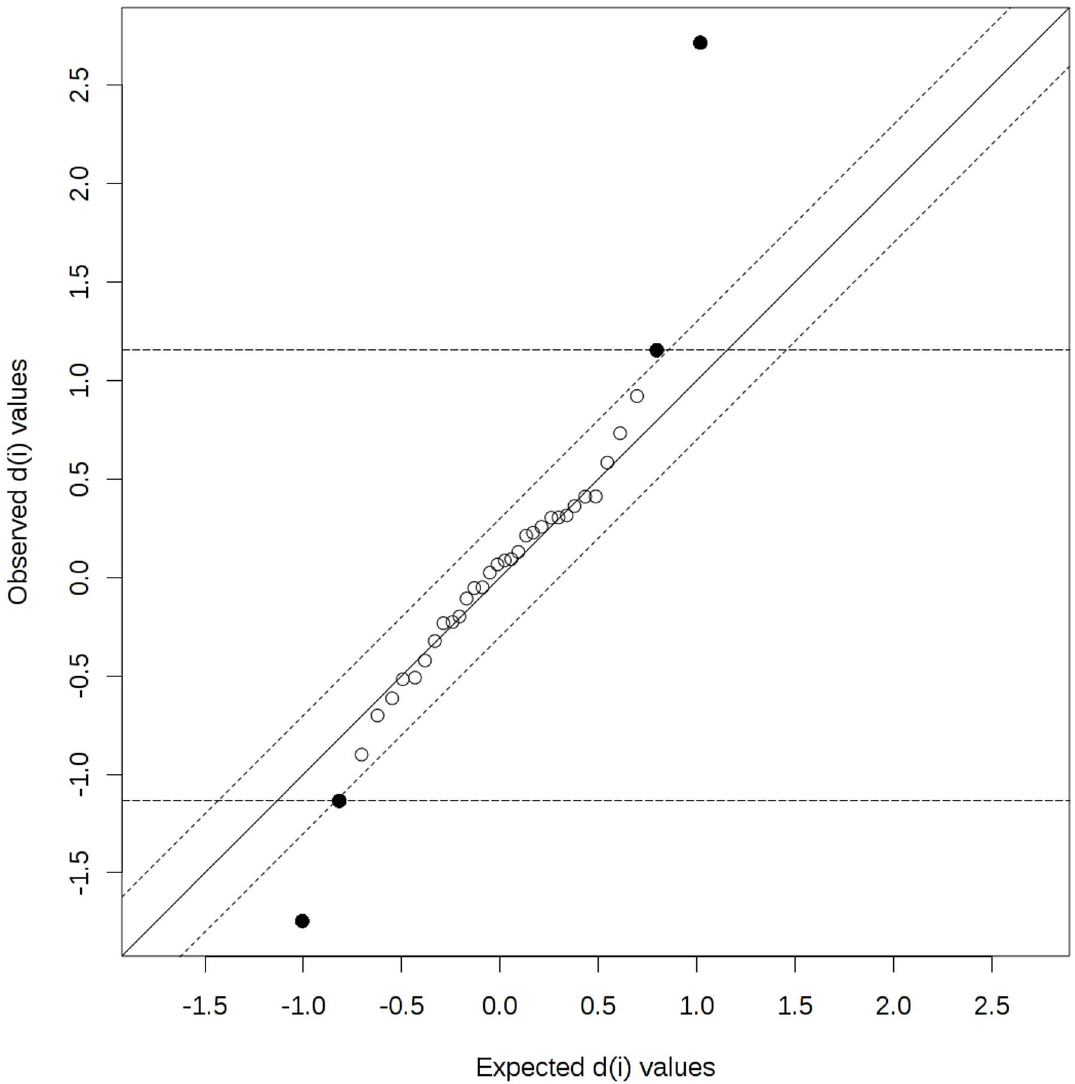
Figure 4. Significant features identified by SAM (Significance Analysis of Microarray (Delta=0.3). The more the variable deviates from the ‘‘observed-expected d’’ line, the more likely it is to be significant. The bold dots represent features that exceed the specified threshold (cutlow=– 1.134, cutup=1.155). Significant positive compounds (i.e. mean concentration in the serum of the beekeepers directly after a bee sting . mean concentration in the serum of the beekeepers after at least six weeks since the last sting): Glu (d.value=2.717), 3MHis (d.value=1.155). Significant negative compounds (i.e. mean concentration in the serum of the beekeepers directly after a bee sting , mean concentration in the serum of the beekeepers after at least six weeks since the last sting): Gln (d.value=–1.744), Met (d.value=–1.134).